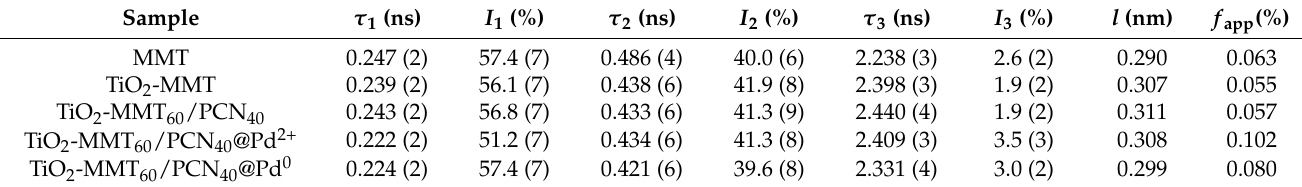
Table 2. Variation in microdefect results obtained from PALS spectra of the TiO 2 -MMT/PCN@Pd nanocomposites with three-lifetime fitting. Experimental errors are given in parentheses in terms of uncertainty of the last meaningful